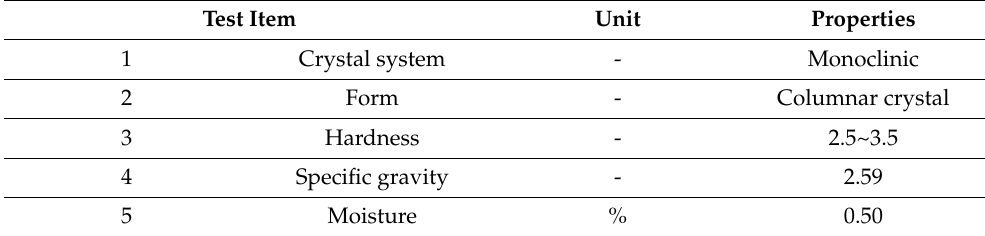
Table 5. Inorganic fillers properties used in the study.